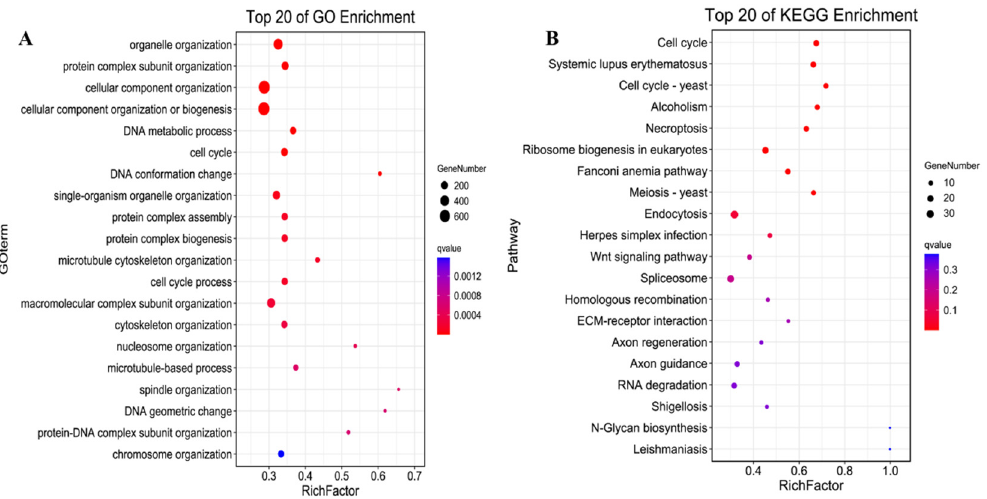
Figure 4. The functional enrichment analysis of the trans-regulation lncRNAs. ( A ) the top 20 significantly changed GO terms of mRNAs; ( B ) top 20 significantly changed pathways associated with mRNAs.